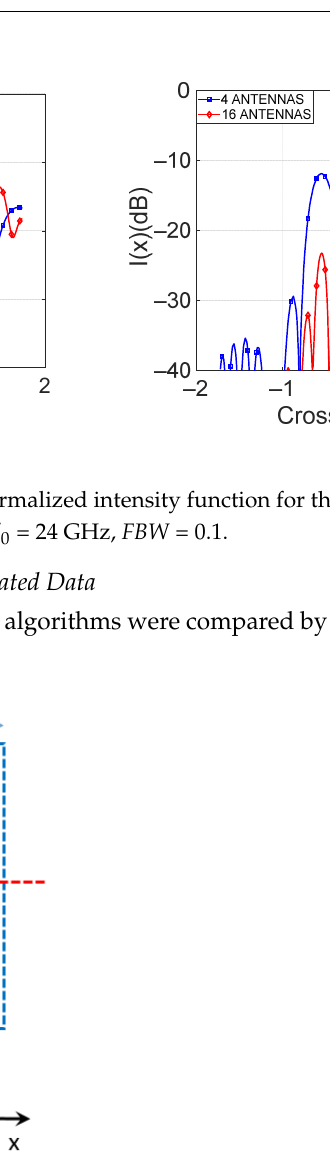
Figure 13. Geometry of the scenario in the x–y plane. Point target 3 m far from the antenna plane and considered ROI (dashed blue line).